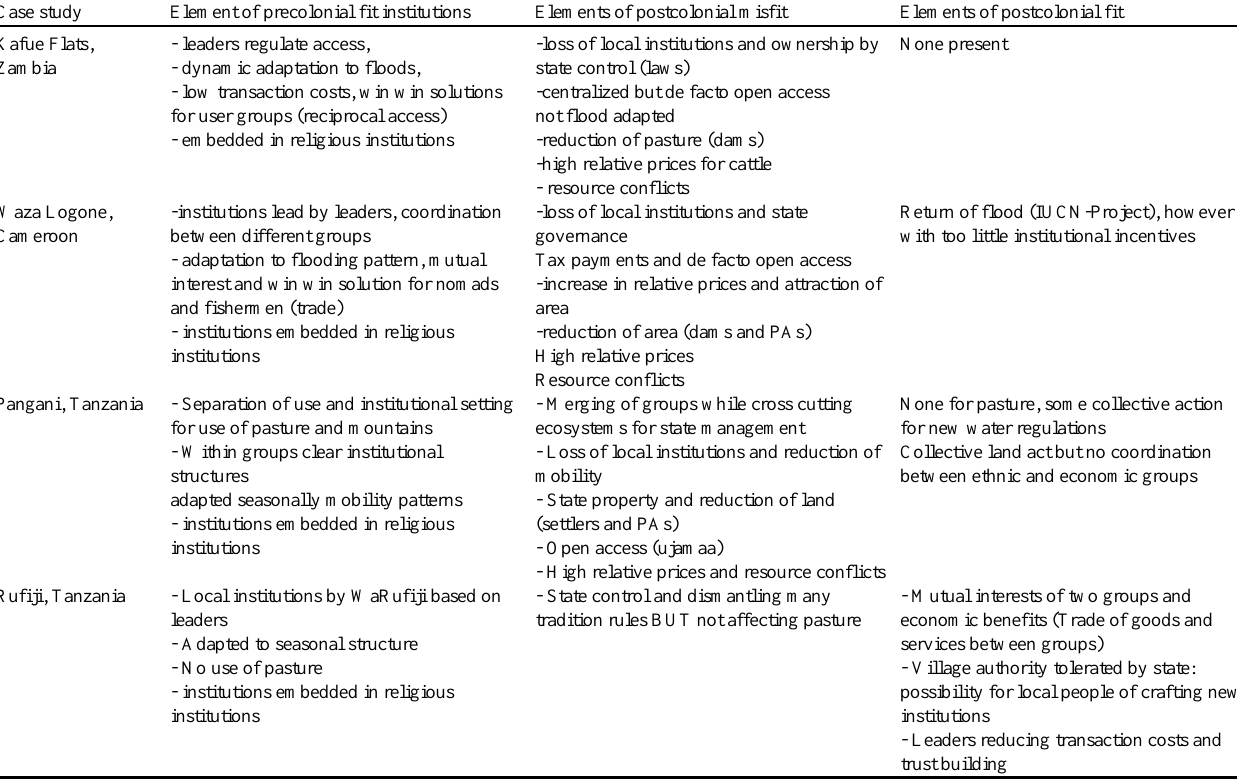
Table 2 . Major findings of the comparison of institutional fit and misfit in four pastoral commons in African Floodplains. Case